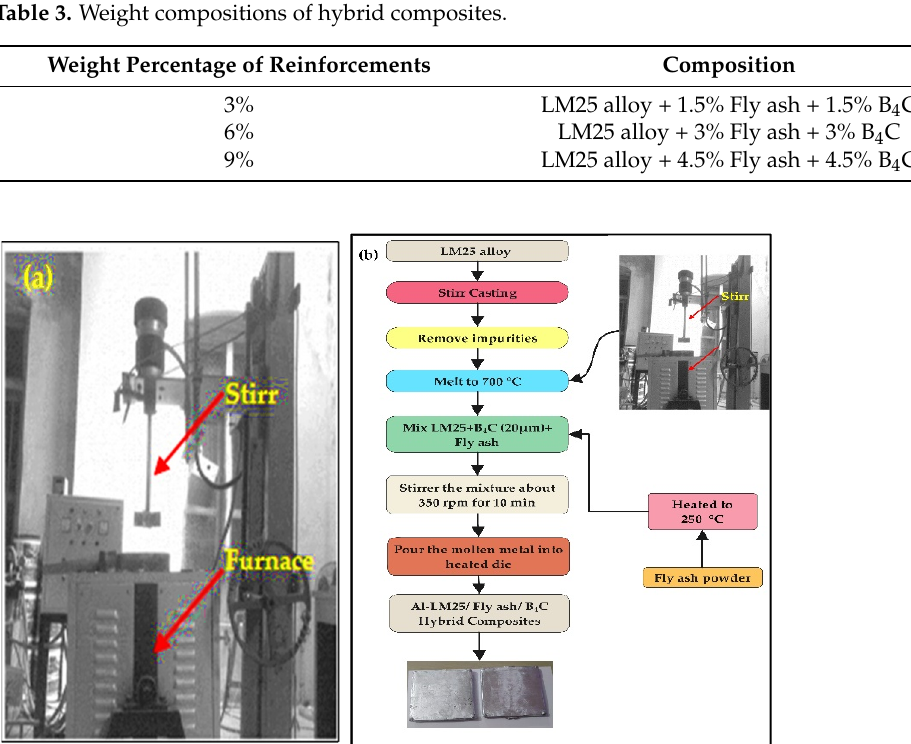
Table 4. Specification of WEDM machine tool